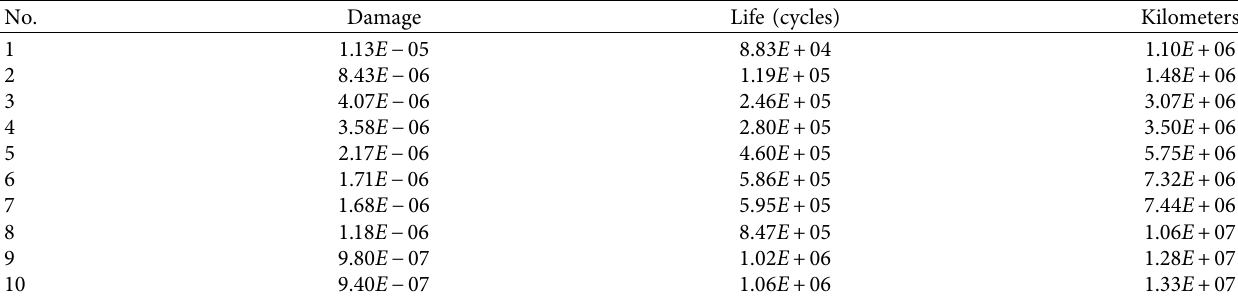
Figure 17: Fatigue life contour after increasing thickness. Table 5: Fatigue life table after increasing